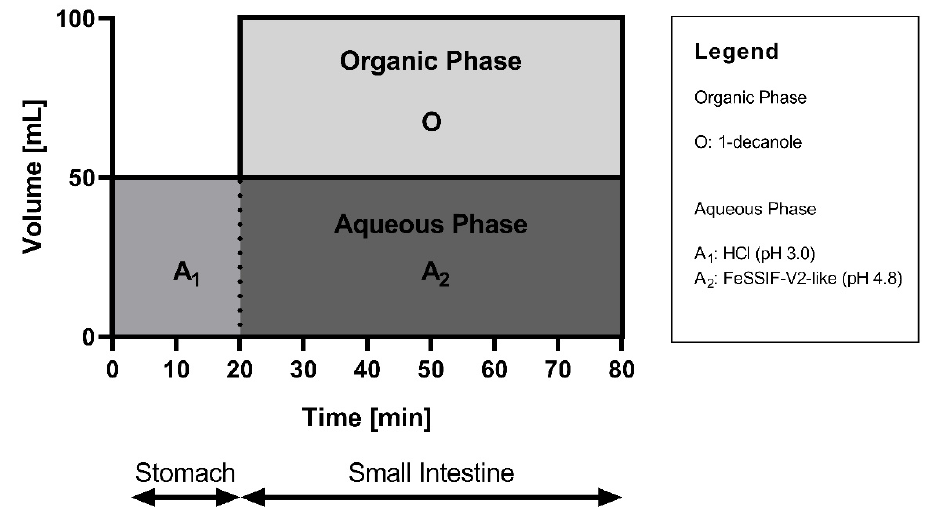
Figure 1. Biphasic dissolution setup for the mouse model.